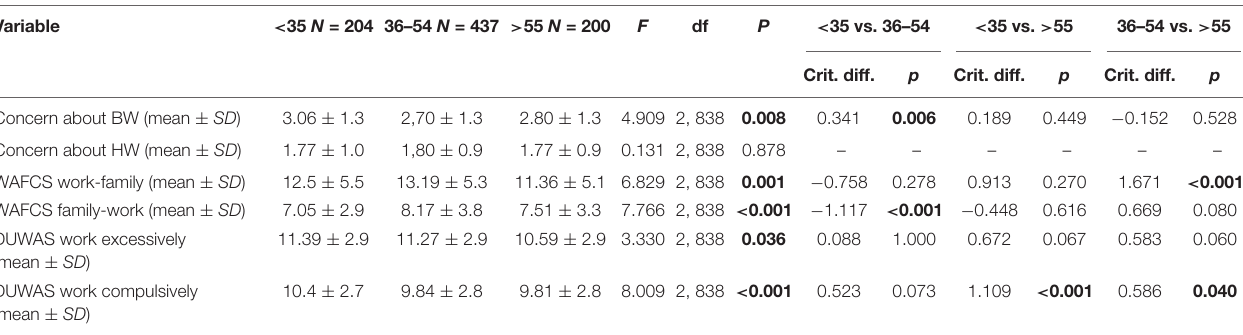
TABLE 5 | Questionnaires scores in the Second Wave group by age class.